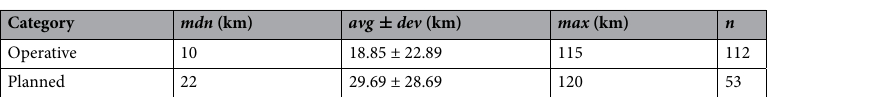
Table 12. Distance from the coastline among 112 operative and 53 planned offshore windfarms investigated in a 2020 offshore wind technology review 49 .